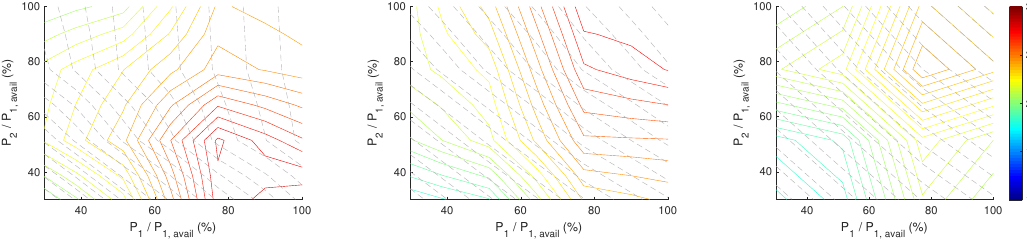
Figure 12. Impact of wind conditions and turbine power set-points on simulated sum blade root flapwise (BRF) damage equivalent loads of two turbine array. Contour lines show sum BRF fatigue loads normalised by the load of upstream turbine in default wind conditions. Grey dashed lines denote contours of same sum power output of turbine array. Wind direction is 0, 10 and 22 degrees from left to right. Default wind conditions are mean wind speed of 8 m/s, turbulence intensity of 7%, and wind direction of 0 degrees, in which direction is aligned with turbine array.